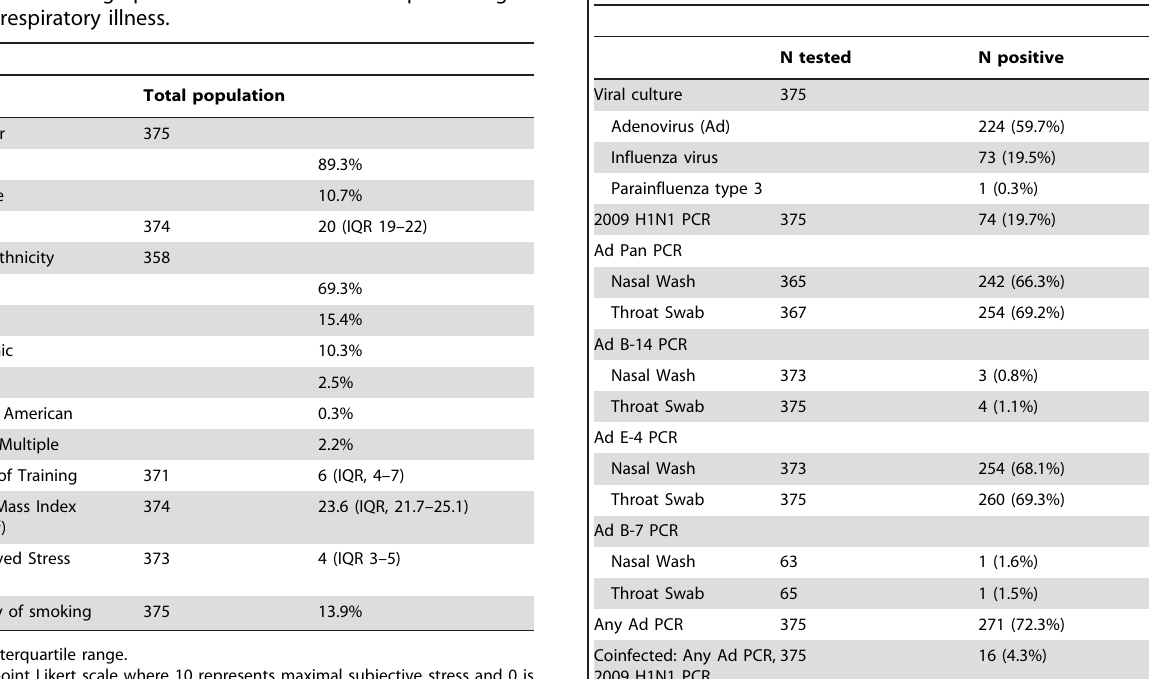
Table 2. Pathogens recovered, by specimen